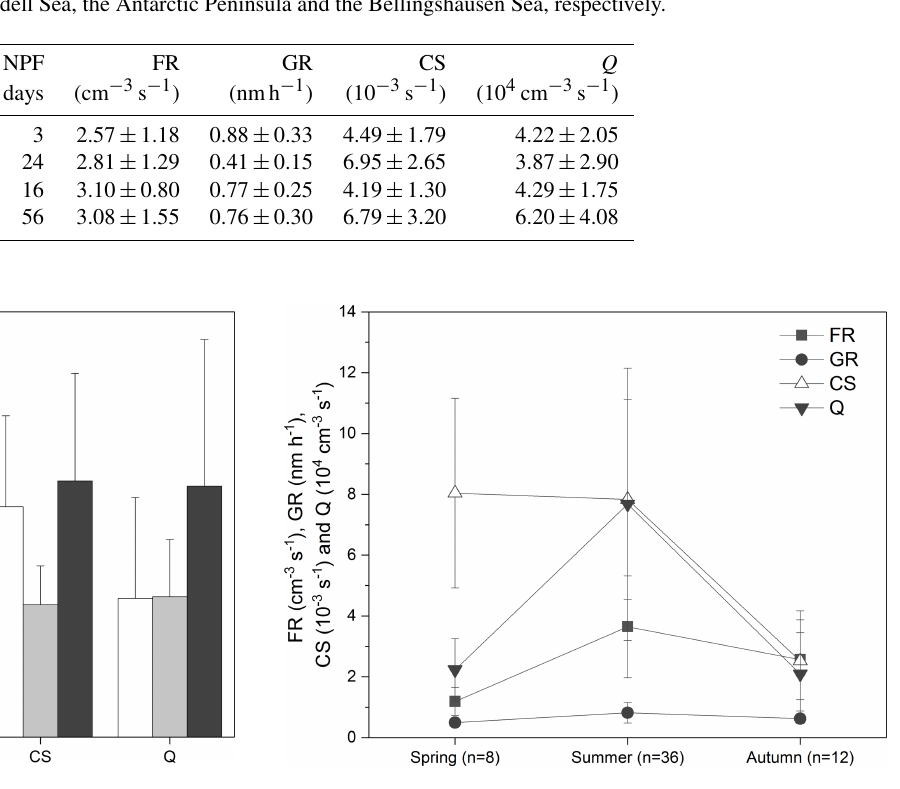
Figure 6. Comparison of NPF characteristics including the forma- tion rate (FR), growth rate (GR), condensation sink (CS) and source rate of condensable vapors ( Q ) depending on the origins and path- way of air masses during the austral summer period. The error bars represent standard deviation.